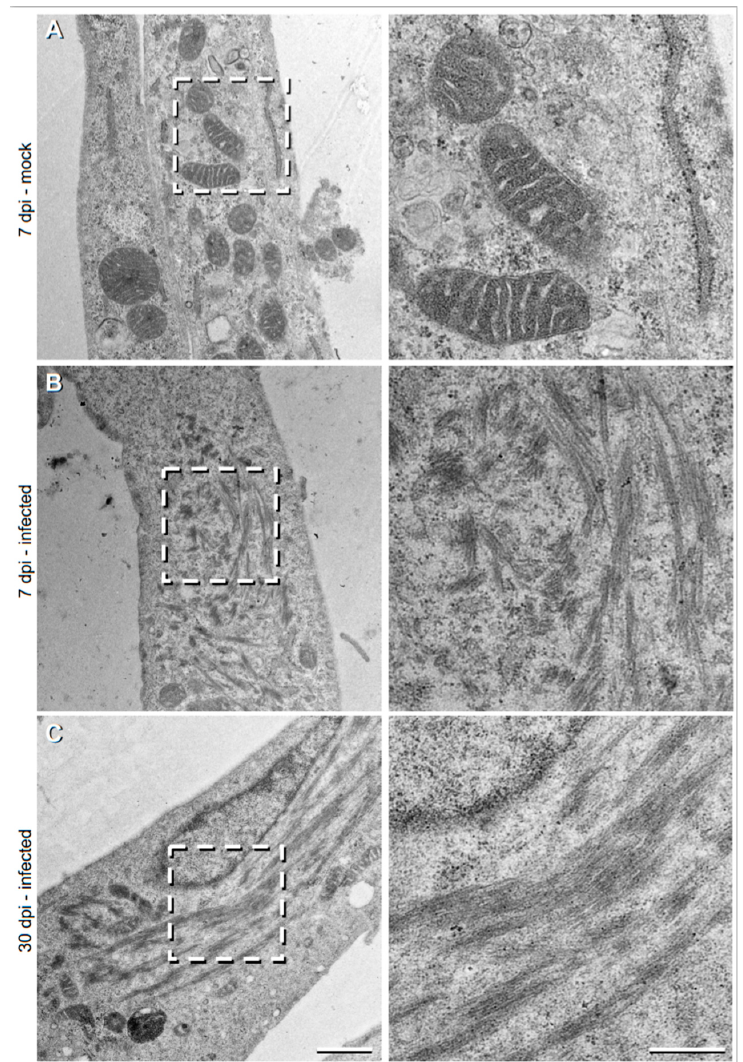
Figure 2. Transmission electron microscopy (TEM) images showing the filamentous structures within the TULV-infected Vero E6 cells. Vero E6 cells, ( A ) mock-infected, or infected with TULV at a MOI of 0.1 at either ( B ) 7 days post infection (dpi) or ( C ) 30 dpi. Higher magnification images from the marked inset regions are shown in the right column. Scale bars represent 500 nm and 1 µm on low and high magnification micrographs, respectively.